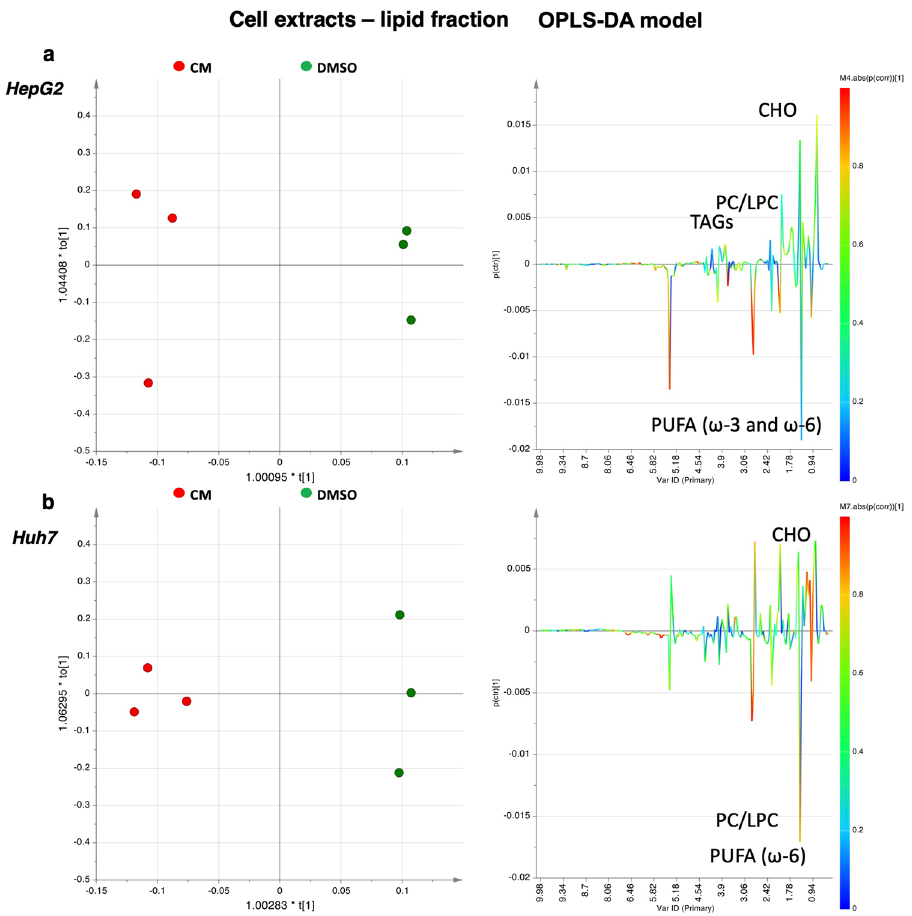
Figure 7. OPLS-DA scores plots (left panel) and corresponding coefficient loading plots (right panel) derived from the 1 H-NMR spectra of ( a ) HepG2 and ( b ) Huh7 cell lipid extracts obtained from different groups. DMSO Vehicle treatment, CM Crithmum maritimum